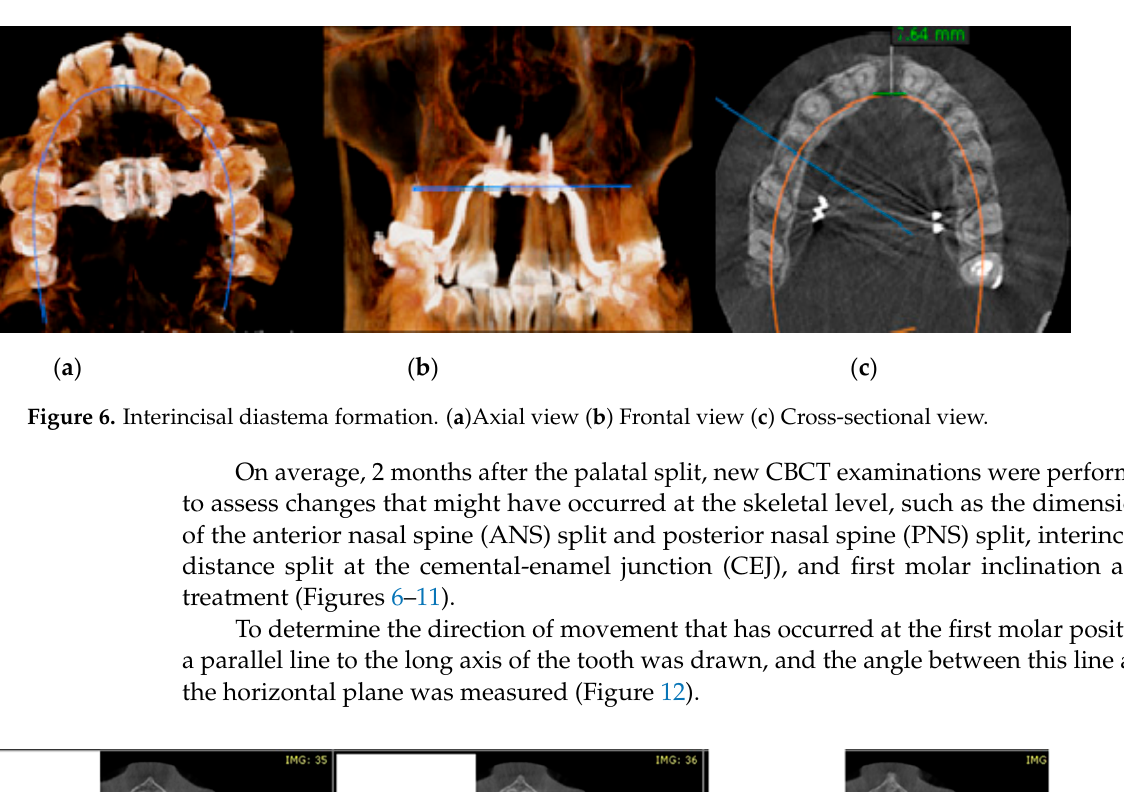
Figure 5. Rendering axial images showing FOV images used in the study before the palatal split. ( a ) Micro-implants in position, ( b ) Device in position.